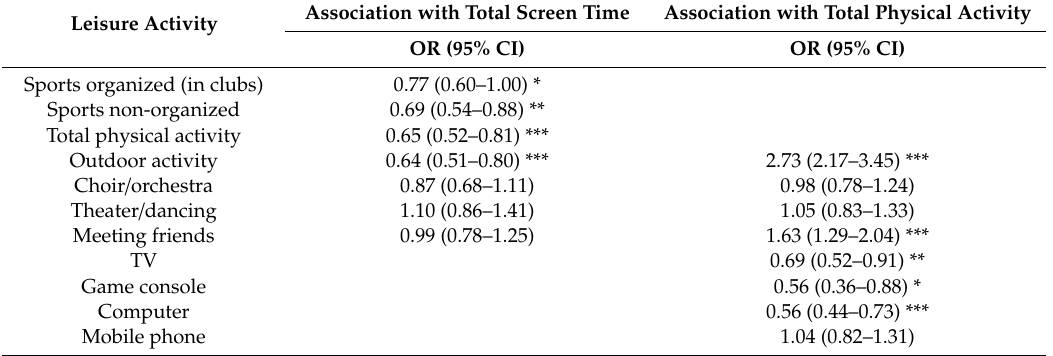
Table 4. Associations of total screen time and total physical activity with other leisure activities ( N = 1449).